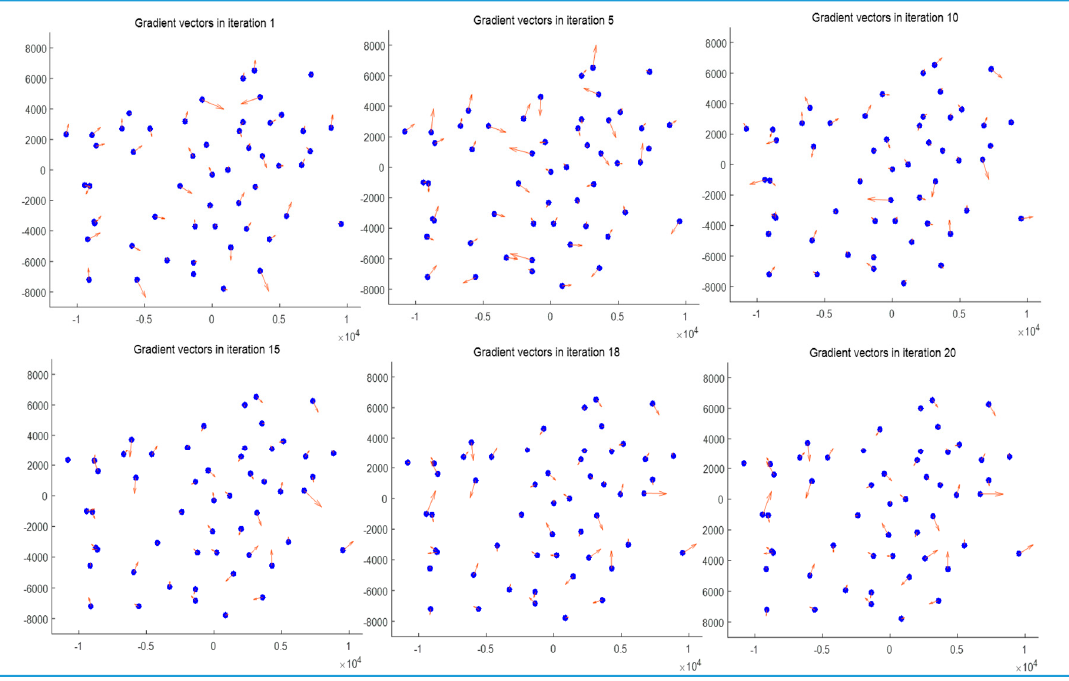
Figure 9. Gradient vectors in surface points 𝒒 (cid:3036)(cid:3038) for some iteration steps (the unit of axes is meters).